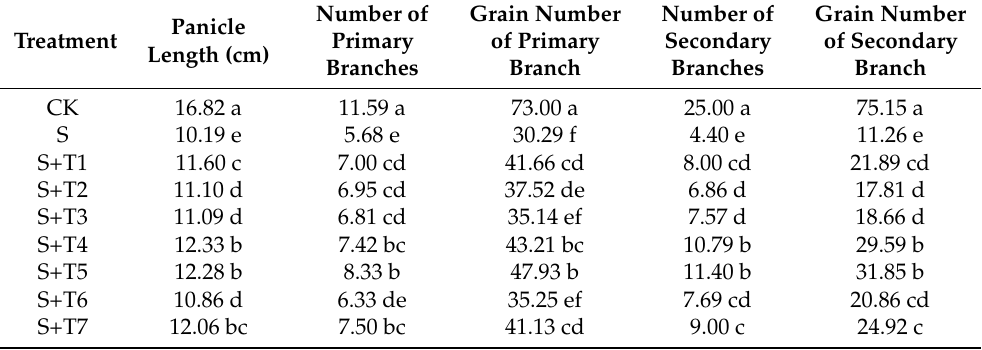
Table 8. Rice panicle